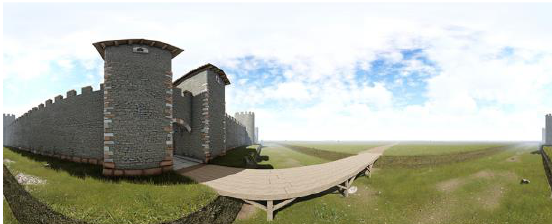
Figure 11. Screenshot of VR immersion in the model of